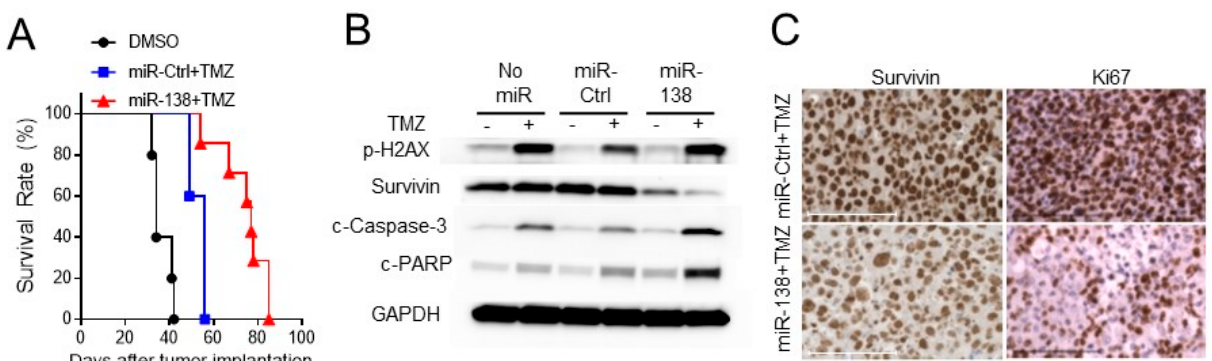
Figure 5. Sensitization of GBM cells by miR-138 reduces tumorigenicity in orthotopic in vivo model. ( A ) Mouse survival Kaplan-Meier survival curve for mouse survival rates. Intracranial xenograft tumor was induced by implanting GBM cells transduced with miR-138 or miR-Ctrl expressing lentiviruses. ( B ) Mice brain tumor tissues were harvested subjected to western blotting to show the expression levels of Survivin. Expression of cleaved Caspase-3 and cleaved PARP was detected to show activation of apoptosis. Phosphorylated H2AX (p-H2AX) was used as an indicator for the DNA damage activity of TMZ. ( C ) Representative immunohistochemistry staining images of mice brain tumor tissue sections for the change of Survivin expression by miR-138. Ki76 was stained for cell proliferation. Scale bars indicate 100 µm.